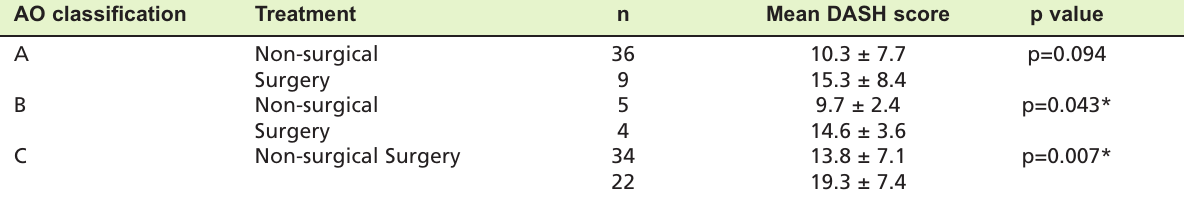
Comparison of DASH score between the different treatment modalities in different types of fracture Table III: AO